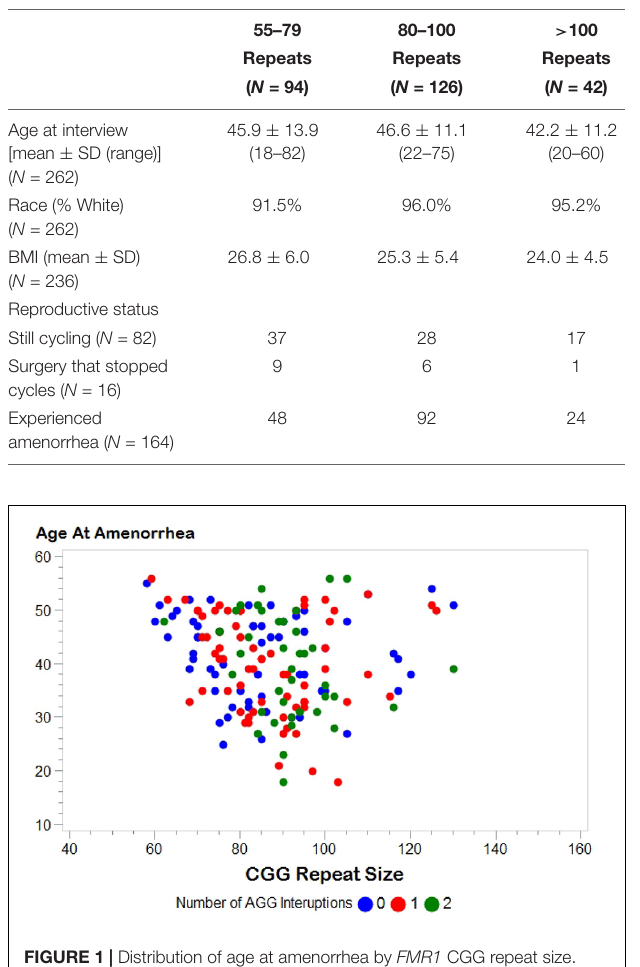
TABLE 1 | Demographics of the study population of women with a premutation.